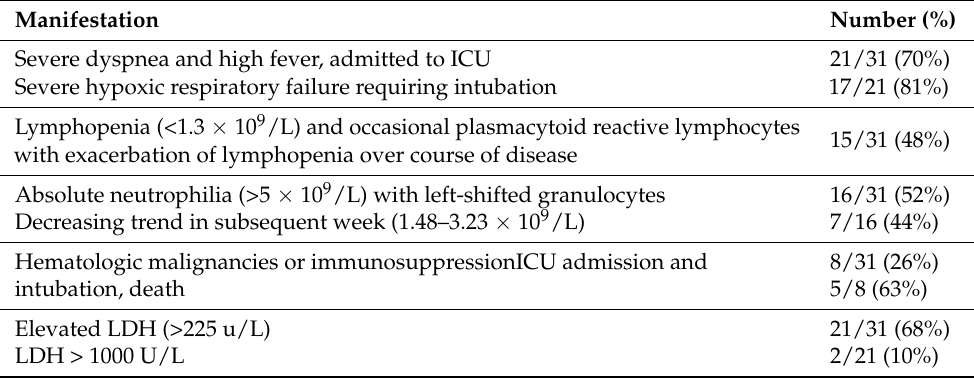
Table 1. Summary of results from laboratory tests and clinical